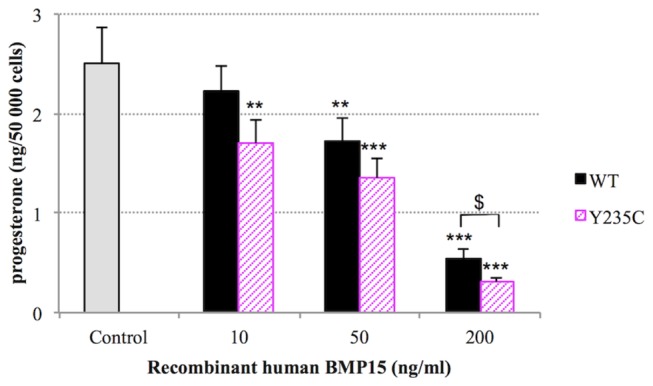
Recombinant BMP15 inhibition of progesterone secretion.Granulosa cells from small antral (1–3 mm in diameter) ovine follicles were cultured for 96 h in serum-free conditions. Cultures were performed in the absence (control) or in the presence of increasing dose (10, 50, 200ng/ml) of wild type recombinant human BMP15wt or BMP15Y235C mutant. Each treatment was tested in triplicate in each of 5 independent experiments. The results represent the amount of progesterone secreted by 50 000 cells between 48 h and 96 h of culture (mean ±SEM). Dose effect was analyzed by one-way ANOVA by comparing each dose to control (**, p<0.01; ***, p<0.001). Mutation effect was analyzed by Student t-test within each dose ($, p<0.05).